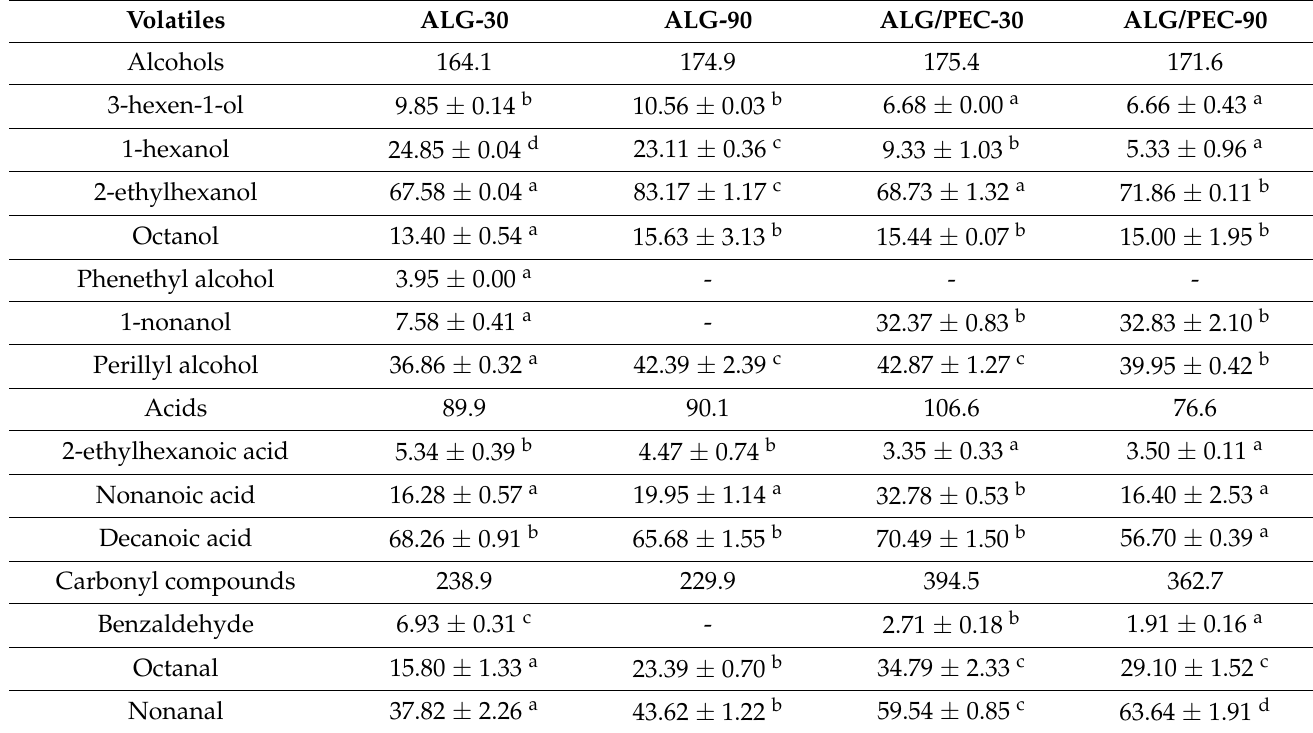
Table 6. Amount ( µ g/100 g) of volatile compounds in chokeberry juice and hydrogel beads containing chokeberry